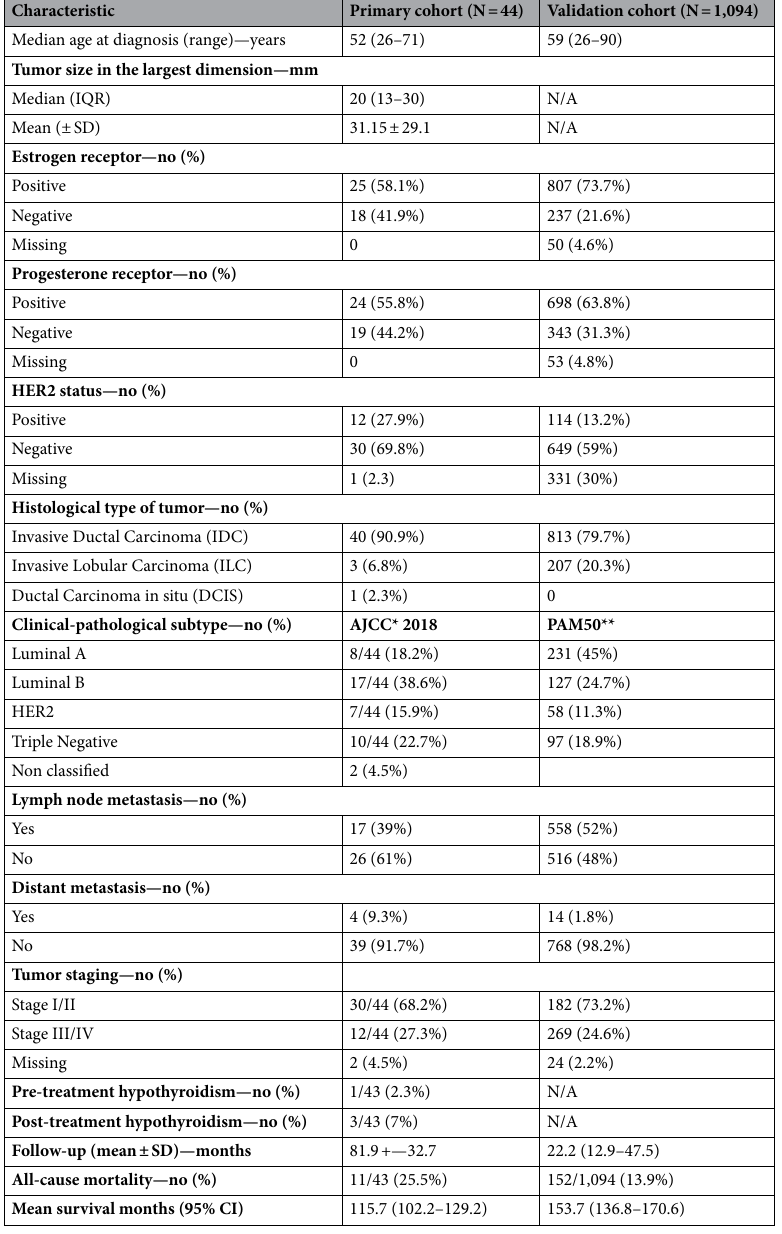
Table 1. Baseline characteristics of patients with breast cancer included in the primary cohort and in the validation cohort. N/A not available, IQR interquatile range, SD standard deviation, HER2 human epidermal growth factor receptor2, AJCC American Joint Committee on Cancer. *Classified by the AJCC 2018 staging system. **Classified by PAM50, data available for 513